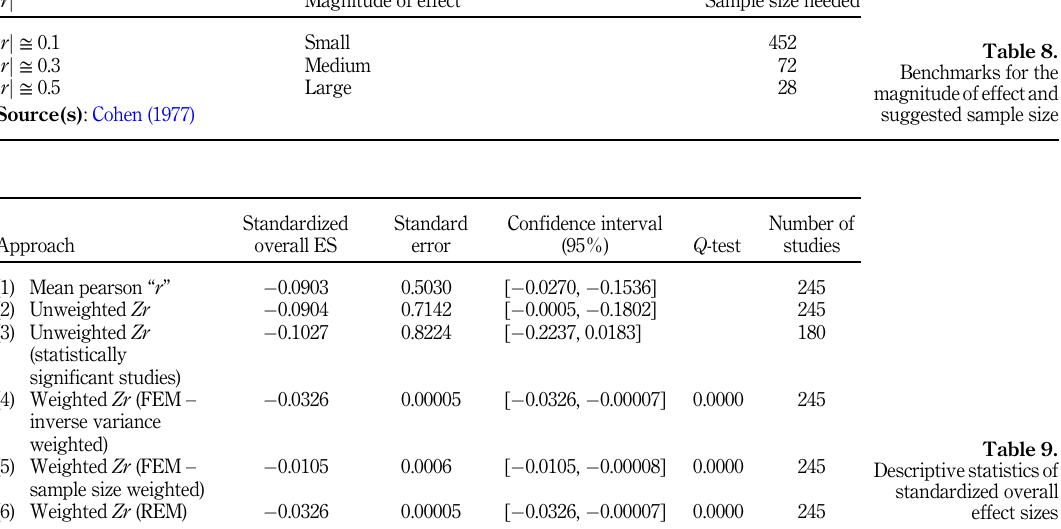
Table 9. Descriptivestatisticsof standardized overall effect sizes